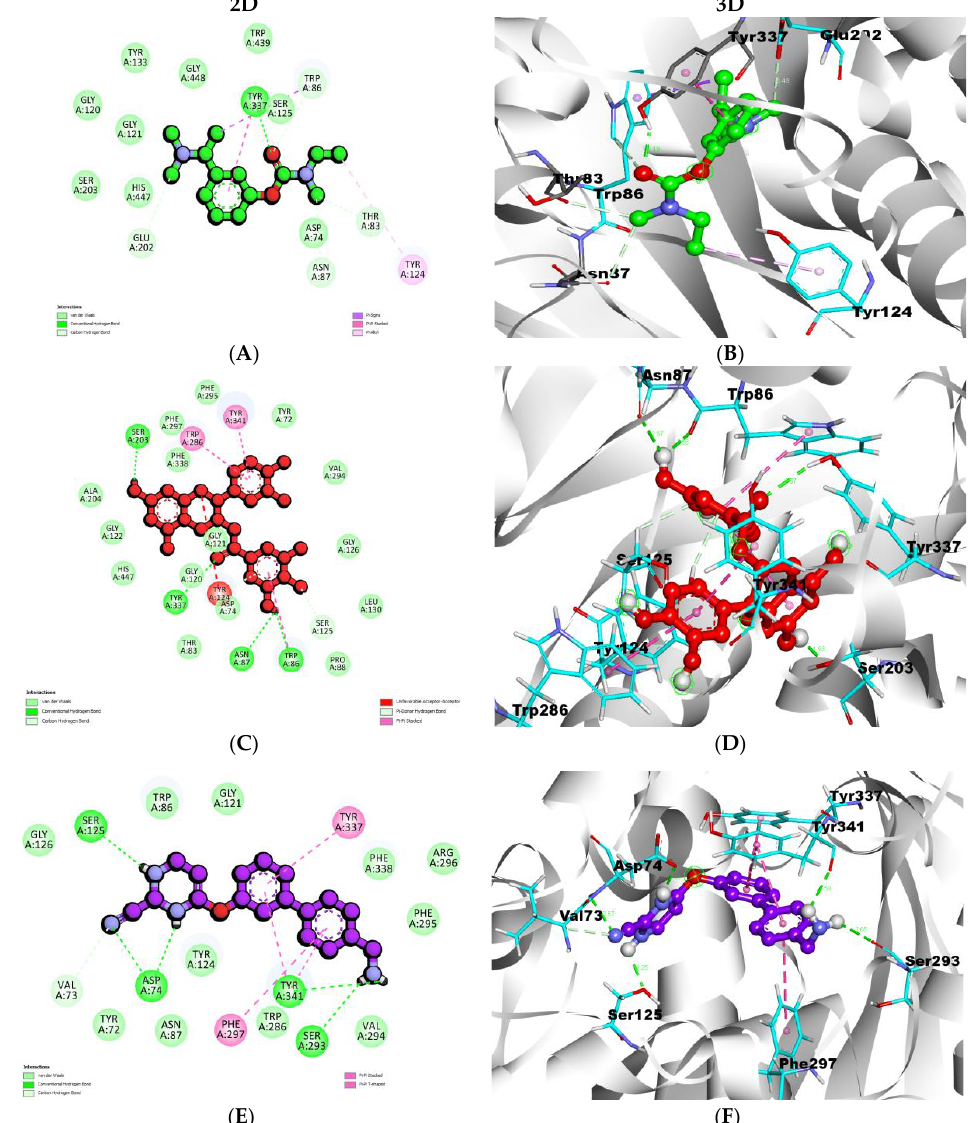
Figure 1. 2D representations ( A , C , E ) and 3D conformations ( B , D , F ) of the interactions of the selected natural compounds with AChE. The BuChE and CID: 163103561 interaction showed a binding affinity of −11.2